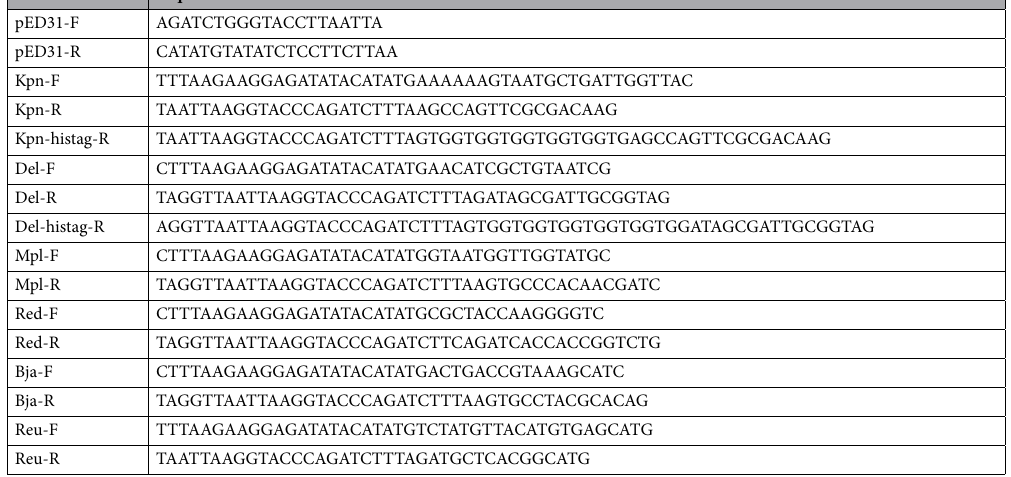
Table 1. The oligonucleotides used in this study.